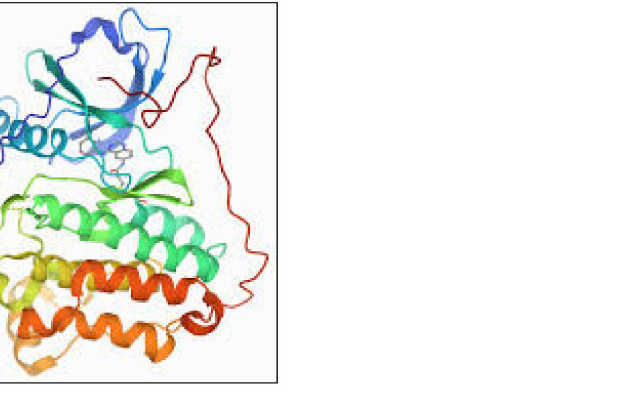
Figure 1. X-ray crystal structure of EGFR tyrosine kinase (PDB: 2J5F) in complex with the 34-JAB. The EGFR of the tyrosine kinase (TK) family, a transmembrane protein, the active site is defined by the presence of residues Phe 723 , Thr 790 , Lys 745 , Gln 791 , Gly 796 , Leu 792